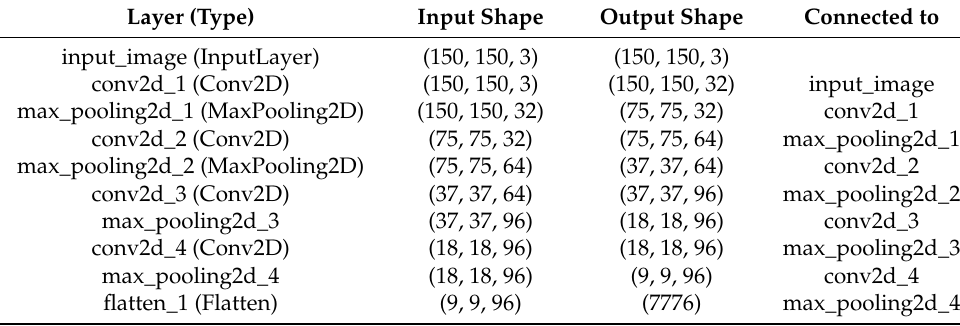
Table 4. Input and output shapes and connectivity of CNN component.